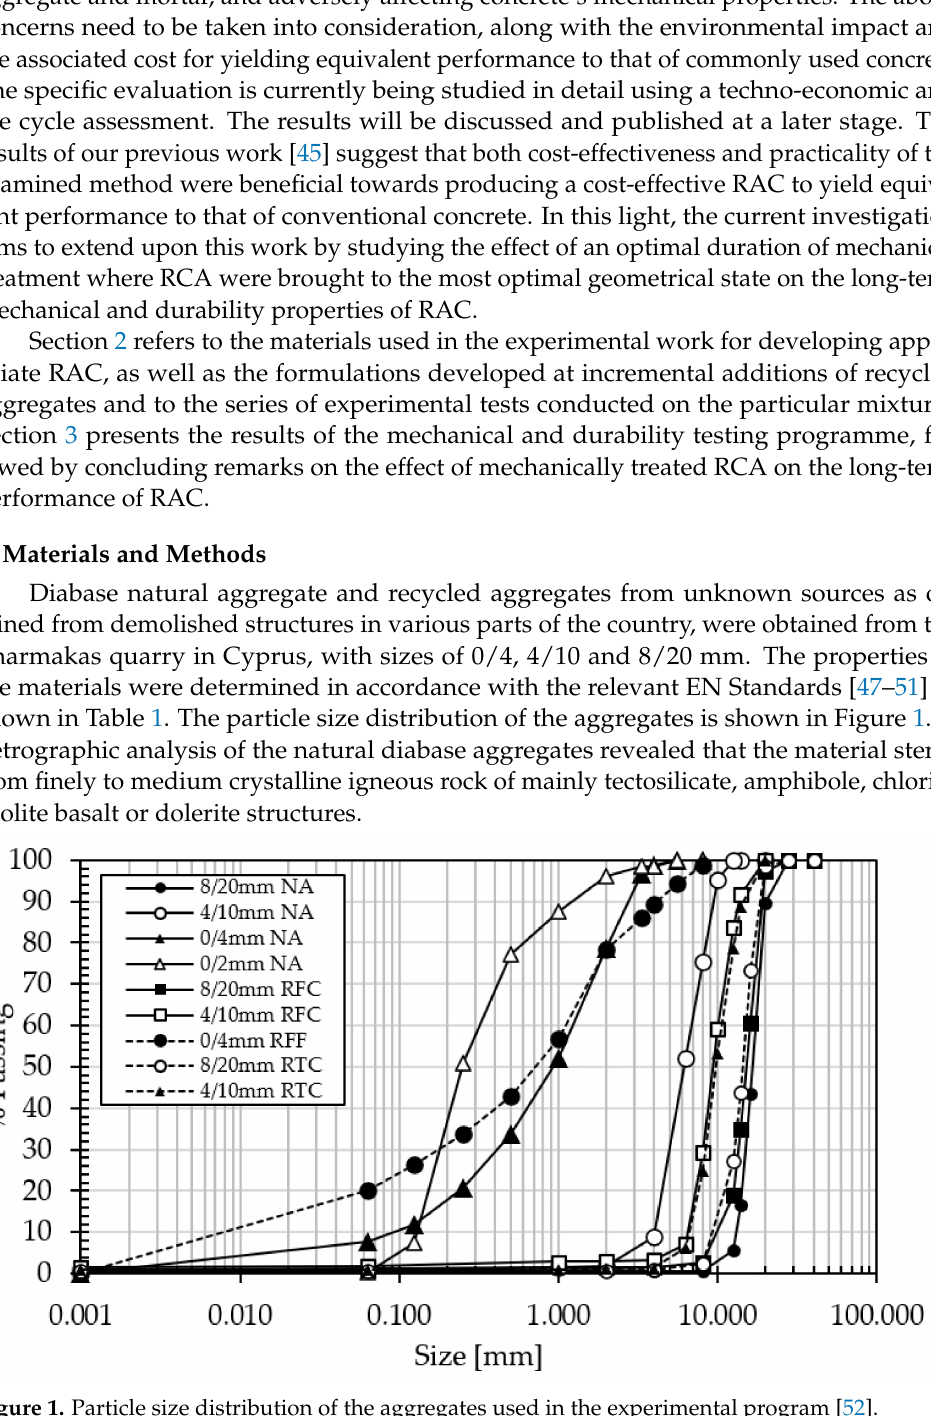
Figure 1. Particle size distribution of the aggregates used in the experimental program